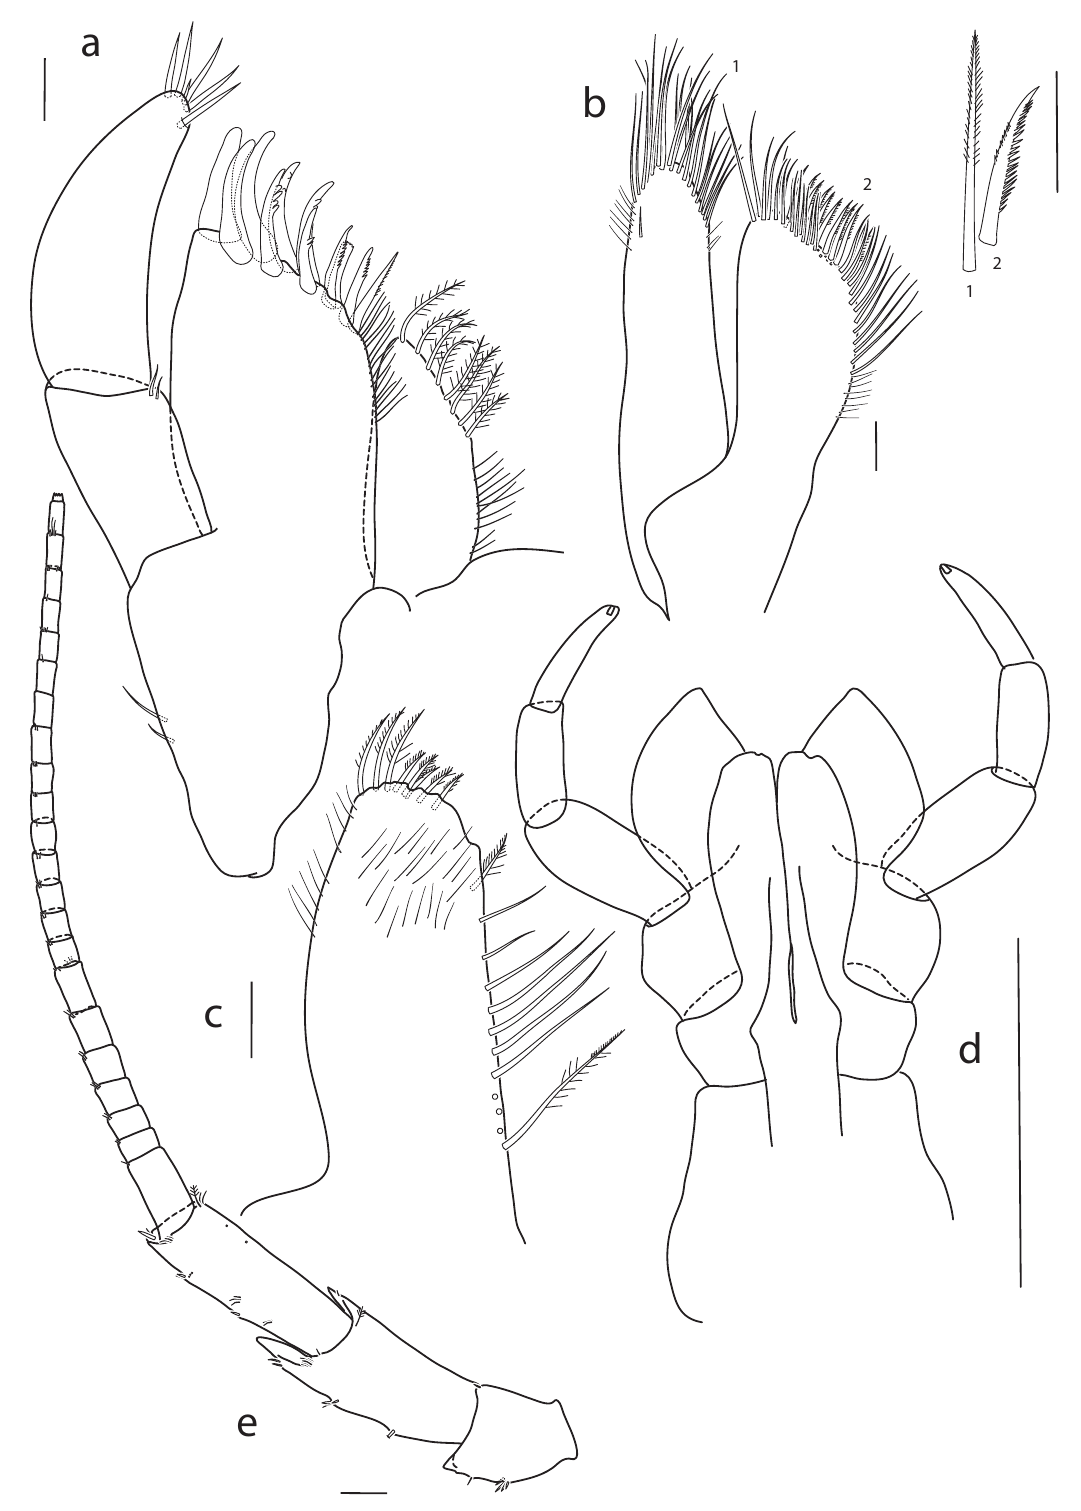
Fig. 19. Labriphimedia vespuccii K.H. Barnard, 1931, ♀, 21 mm (ZMB 34096). a . Maxilla 1. b . Maxilla 2. c . Inner plate of maxilliped. d . Outlines of maxilliped, setae omitted. e . Antenna 2. Scale bars: a–c = 100 µm; d = 1 mm; e = 200